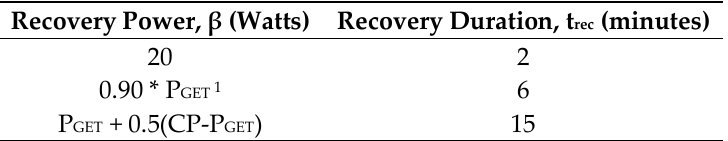
Table 2. Recovery powers and durations.